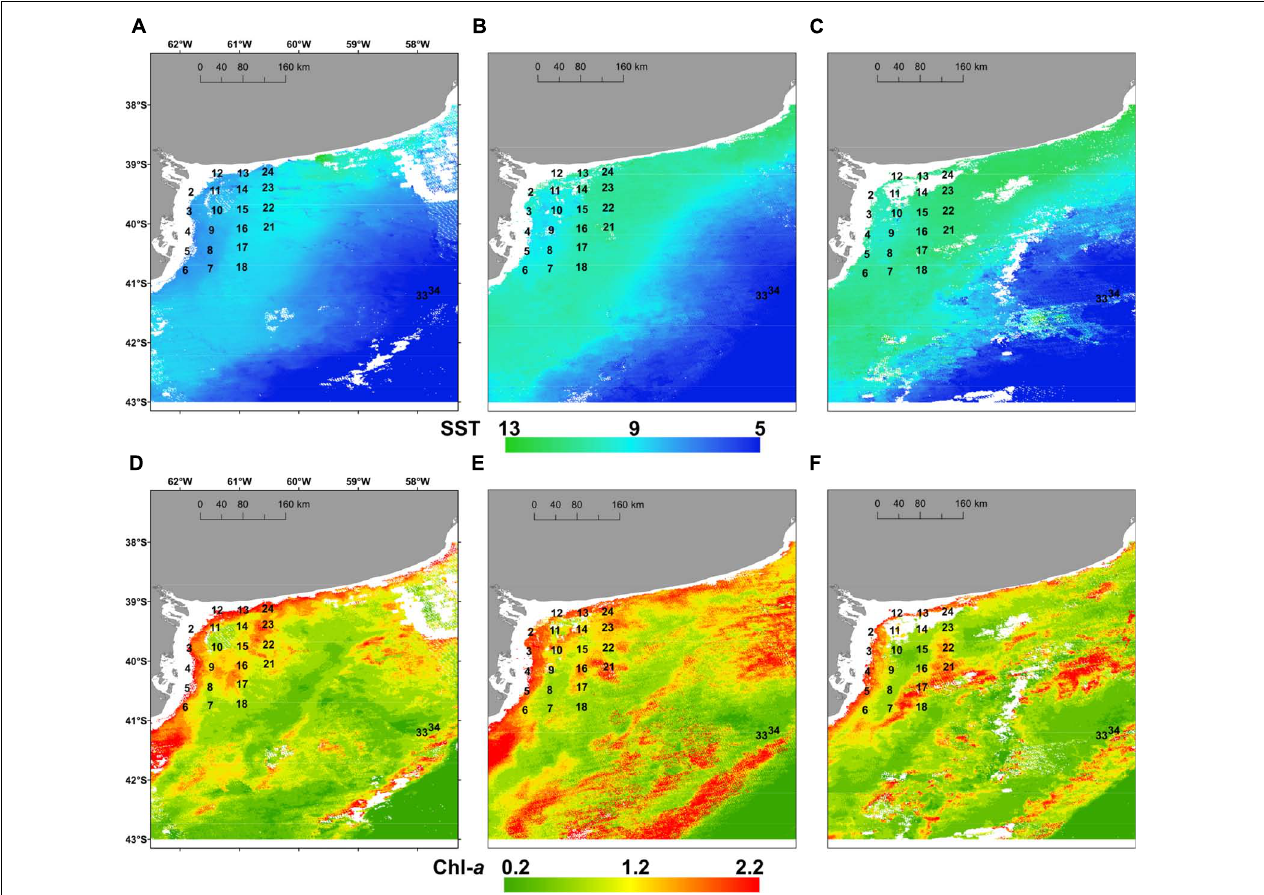
FIGURE 2 | Mean sea surface temperature, SST ( ◦ C) (upper panels) and mean surface chlorophyll a , chl- a ( µ g L - 1 ) (lower panels) registered by satellite images in the study area for the periods: (A,D) 15th–31st August 2015; (B,E) 1st–15th September 2015 and (C,F) 16th–30th September